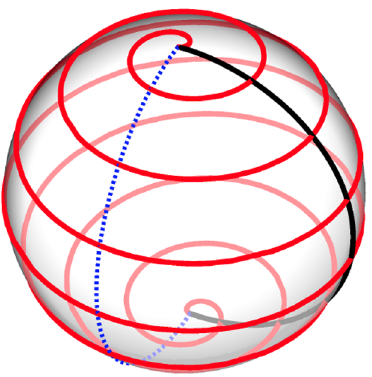
Figure 13 . Feynman diagram contributing to the correlation function between one operator of the type (5.1) and its conjugate. These operators consist of a Z and an X (cid:12)eld and any con(cid:12)guration of derivatives. At l loops the red Z line spirals l times around the black X line. Along the way, it also crosses the dashed blue twist cut l